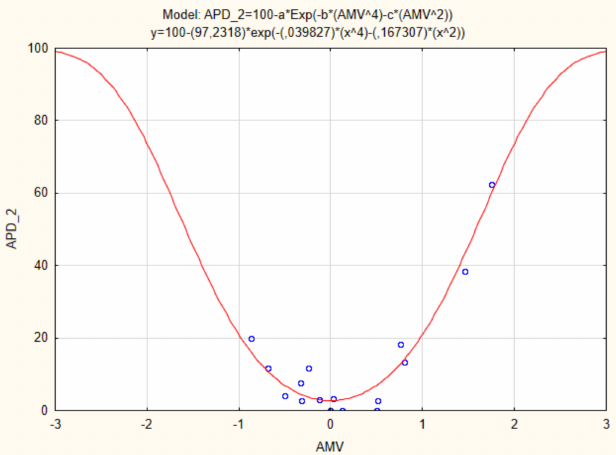
The minimum value of this curve (AMV = 0) was 41.83%. Figure 7 shows the curve for APD_2.